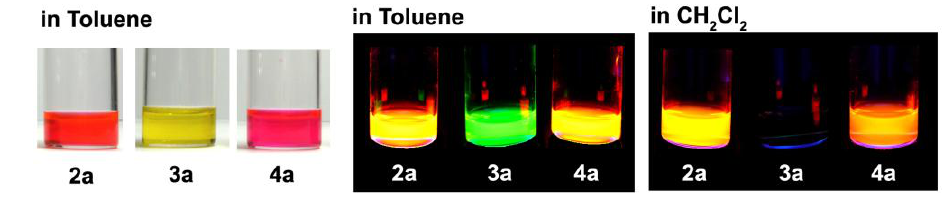
Figure 19. Photographs of solutions of 2a , 3a and 4 under daylight (left), and UV irradiation (middle and right).